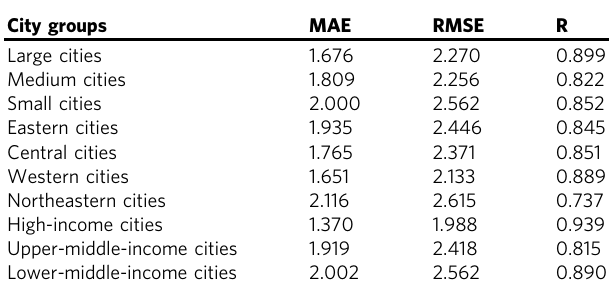
Table 1 ANN model performance for cities in different groups.